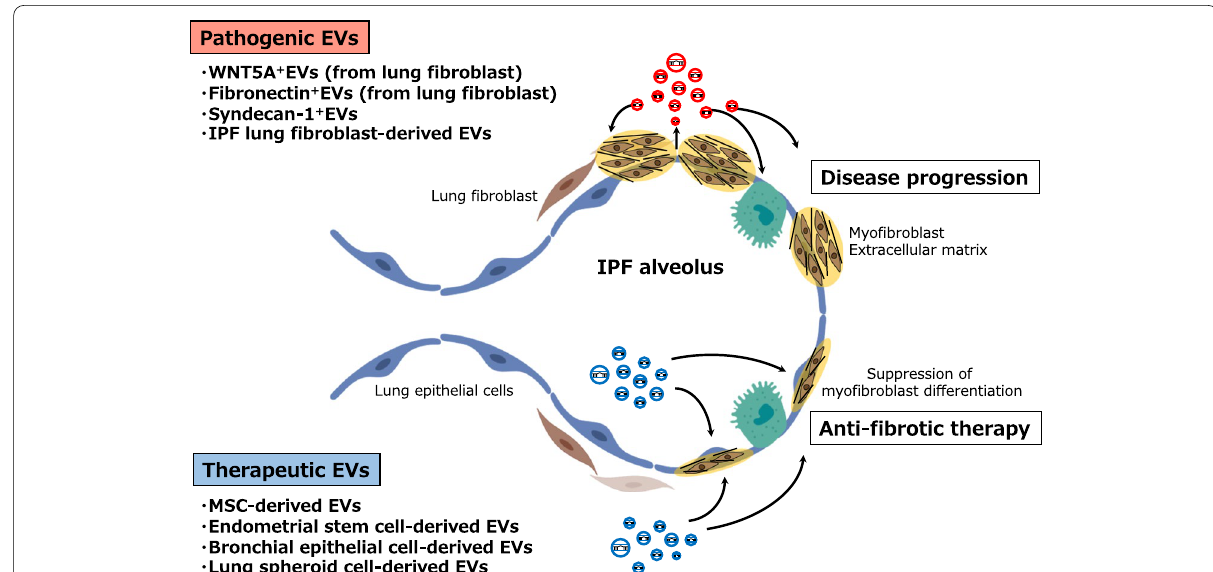
Fig. 1 Extracellular vesicles in IPF: pathogenesis and therapeutics. In IPF lungs, pathogenic EVs mainly derived from lung fibroblasts can induce disease progression through their component cargoes, such as WNT5A, fibronectin, syndecan-1, or miRNAs. In contrast to this, therapeutic EVs derived from MSCs, endometrial stem cells, bronchial epithelial cells, or lung spheroids can inhibit myofibroblast differentiation and induce the degradation of extracellular matrix via shuttling of